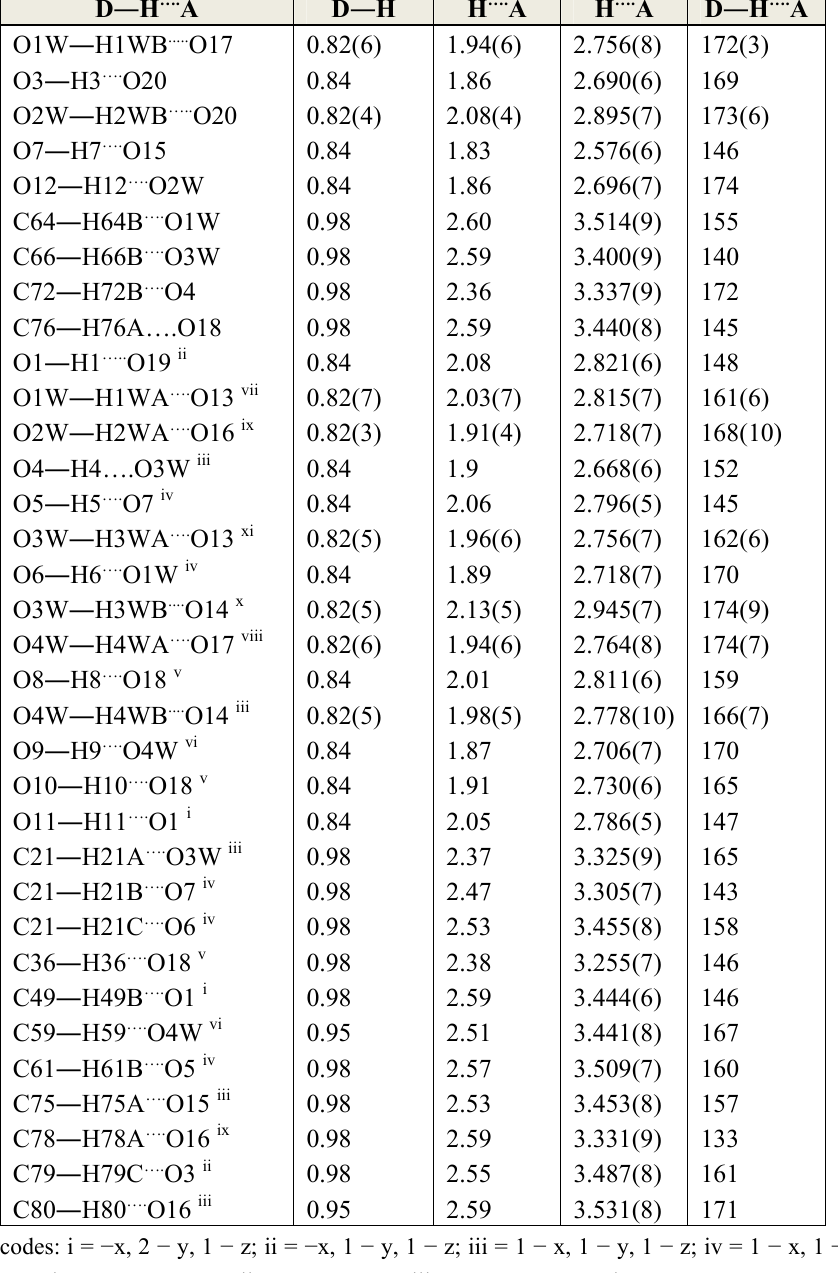
Table 2. Hydrogen geometric parameters (Å) of C-5-bromo-2-hydroxyphenylcalix[4]-2-